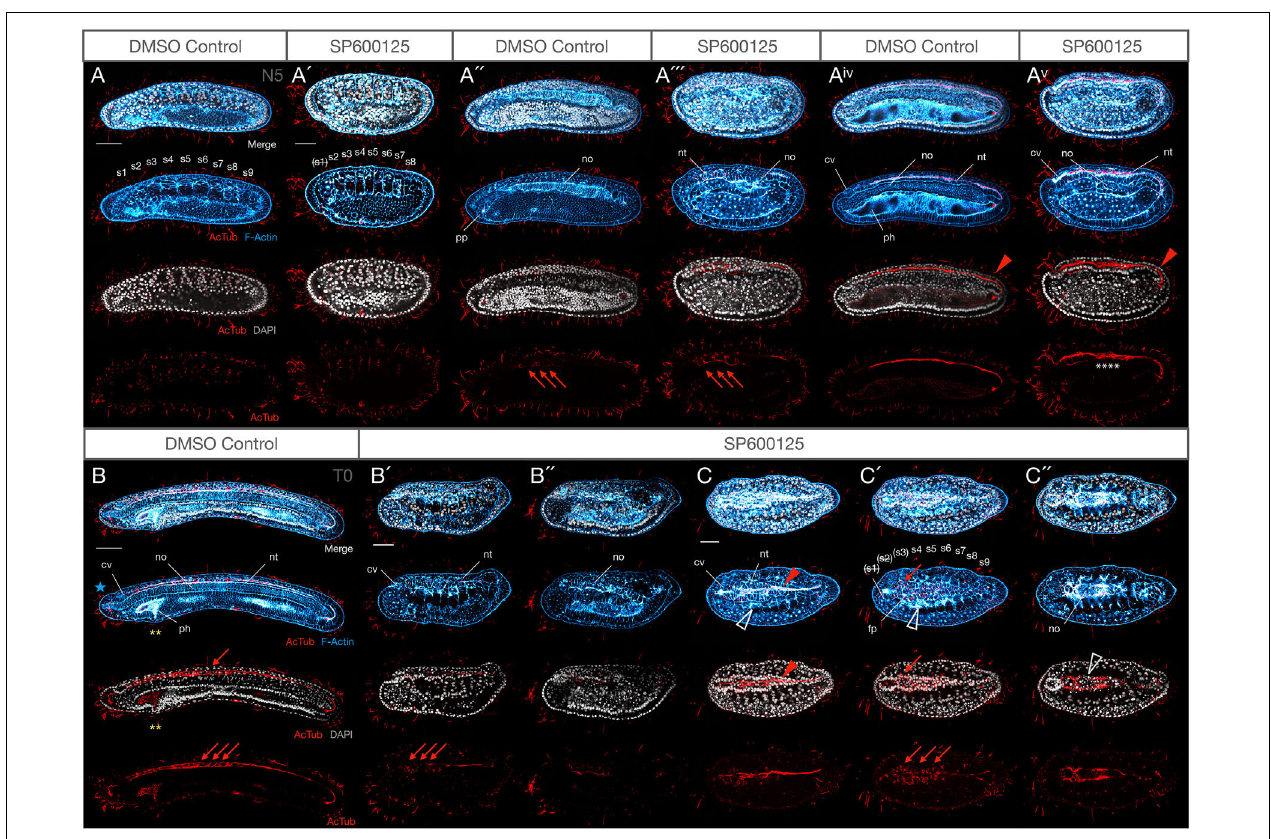
FIGURE 5 | Weak JNK inhibition allows embryogenesis to proceed to N5 and T0 stages, including axonogenesis, but mesodermal structures are still affected. (A–A v ) N5 stage control and 2.5 µ M SP600125-treated embryos at equivalent confocal planes. At N5, DMSO controls possess nine somite pairs (A) , a clear ciliated preoral pit (A (cid:48)(cid:48) ) , and the central canal of the nerve cord is populated by an axonal tract extending from the neuropore of the cerebral vesicle to the neurenteric canal ( A iv , red arrowhead). Treated embryos have no more than eight somites, and the first is degrading as shown by pycnotic nuclei [ A (cid:48) , indicated by (s1)]. There is no evidence of a preoral pit (A (cid:48)(cid:48)(cid:48) ) , but peripheral axon tracts envelop neurons ( A (cid:48)(cid:48)(cid:48) , red arrowheads) and axons extend through the neural tube (A v ) similarly to controls. The notochord is highly disorganised and no pharynx proper develops. Some branching defects are evident within the central axonal tract (white asterisks). (B–C (cid:48)(cid:48) ) T0 stage control and 2.5 µ M SP600125-treated embryos. The T0 control has more developed anterior structures, including anterior extension of the notochord past the cerebral vesicle ( B , blue star), and cellular reorganisation of the pharynx presaging perforation (yellow asterisks). In treated embryos, the anterior endoderm remains simplified and filled with pycnotic cells (B (cid:48) ,B (cid:48)(cid:48) ) there is no extension of the notochord past the cerebral vesicle, and anterior somites continue to degenerate (C–C (cid:48)(cid:48) ) . Nevertheless, muscle fibres differentiate ( C,C (cid:48) , white arrowheads) and axons project contralaterally in the anterior neural tube dorsal to a pycnotic and disorganised, albeit partially differentiated, notochord ( C (cid:48)(cid:48) , white arrowhead). In all cases, anterior is to the left. Panels (A–A v ) and (B–B (cid:48)(cid:48) ) are lateral views; (C–C (cid:48)(cid:48) ) are dorsal views. (A,A (cid:48)(cid:48) ,A iv ) , (A (cid:48) ,A (cid:48)(cid:48)(cid:48) ,A v ) , (B (cid:48) ,B (cid:48)(cid:48) ) , and (C,C (cid:48) ,C (cid:48)(cid:48) ) are different confocal planes of the same embryos. Representative embryos are shown. Acetylated-tubulin immunoreactivity is in red, F-Actin labelled membranes are in blue, and DAPI stains nuclei in grey. cv, cerebral vesicle; fp, floor plate; nt, neural tube; no, notochord; s1, s2, etc., numbered somites; ph, pharynx; pp, preoral pit. Scale bars = 50 µ